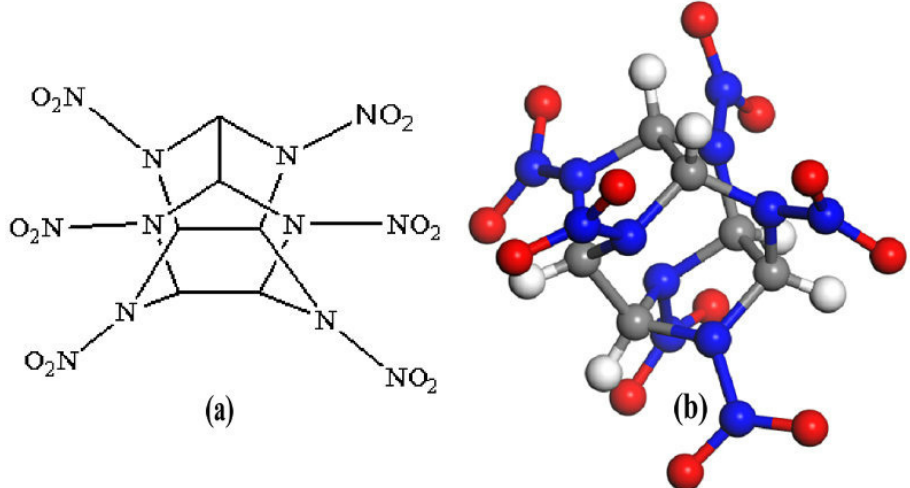
Figure 1. ( a ) chemical diagram of CL-20, ( b ) molecular structure of a CL-20 molecule corresponding to the chemical diagram.